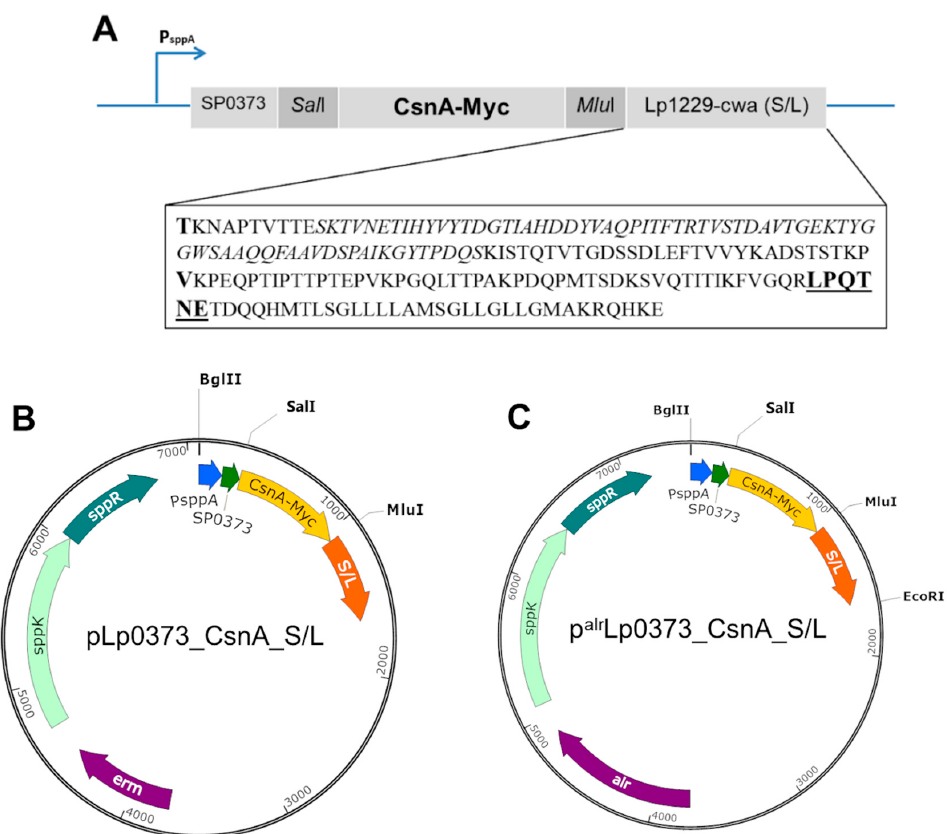
Figure 1. The expression cassette ( A ), erm -based and alr -based expression vectors ( B , C ) of C-terminal cell-wall anchor of chitosanase (CsnA) in L. plantarum . ( A ) Myc tag sequence was fused to the C-terminus of CsnA for protein detection. All parts of the expression cassette can be easily exchangeable using the indicated restriction enzymes ( Bgl II, Sal I, Mul I, EcoR I). The signal peptide (SP) derived from Lp_0373 was fused to CsnA via Sal I site. The short anchor S (85 residues) consists of a linker of 47 residues between the LP × TG motif, which is the consensus sequence LPQTNE in L. plantarum [30,31] (bold, underlined), and the C-terminus of CsnA-Myc with a valine as the fusing point (V in bold). The long anchor L (194 residues) contains a linker of 156 residues upstream of the LP × TG motif including one Mub B2-like domain of 69 residues (mucus binding domain; in italics) fused to CsnA-Myc with a threonine residue (T in bold). ( B ) Schematic overview of the plasmid encoding CsnA fused to a LP × TG cell wall anchor using di ff erent lengths of Lp_1229 derived anchor and Lp_0373 derived SP for secretion. The plasmid contains an erythromycin antibiotic resistance gene ( erm ) as selection marker.